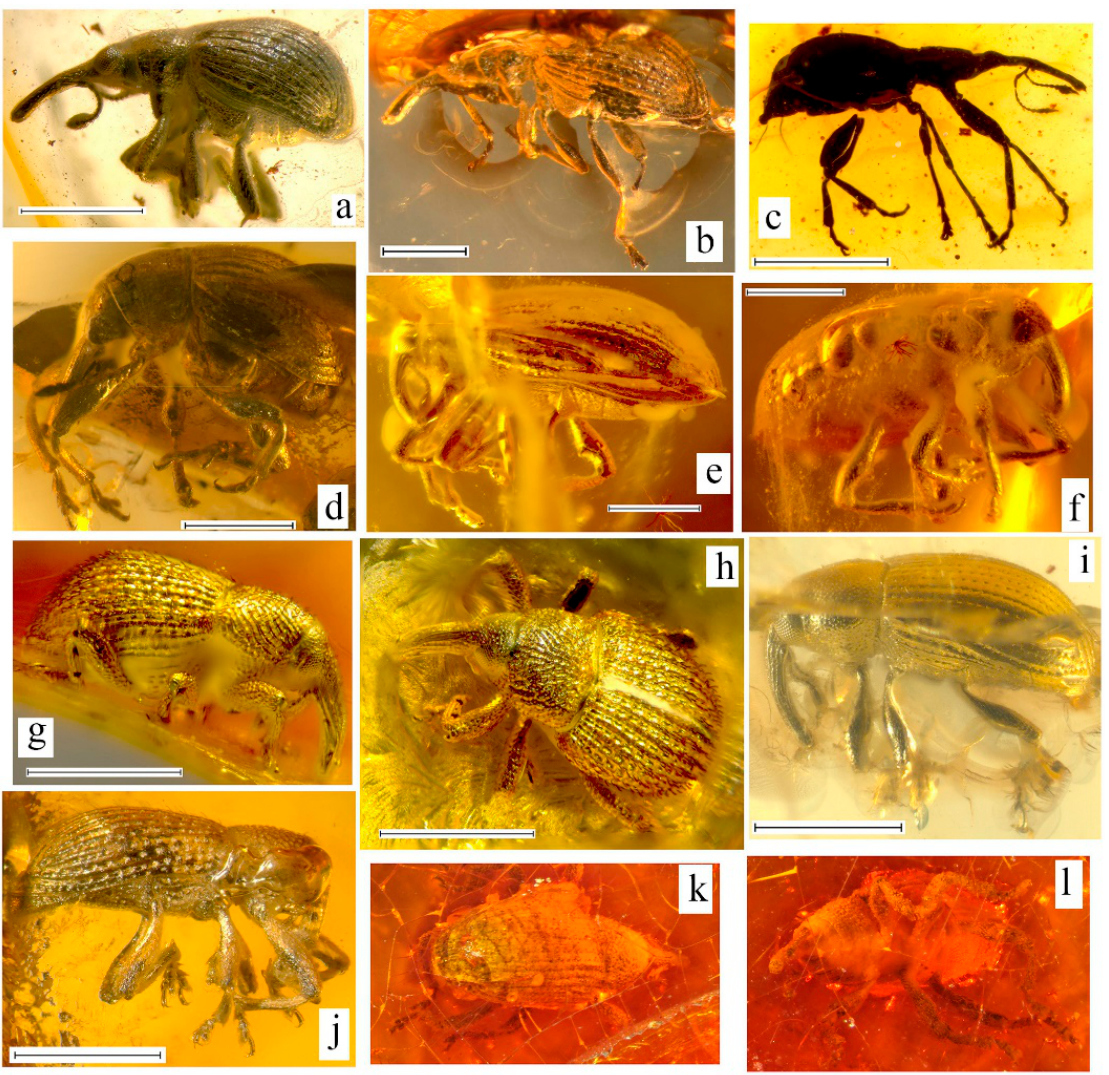
Figure 5. Habitus of Brentidae and Curculionidae from Baltic amber. ( a ) Melanapion poinari , holotype, ISEA , no. BA2013 / 22, body, laterally. ( b ) M. wanati , holotype, ISEA , no. BA2012 / 5, body, laterally. ( c ) Conapium alleni , holotype, ISEA , no. BA2012 / 2, body, laterally. ( d ) Baltonanophyes crassirostre , holotype, ISEA , no. BA2017 / 10, body, laterally. ( e , f ) Dorytomus korotyaevi sp. nov. , holotype, ISEA , no. BA2015 / 6: body, laterally, left ( e ); body, laterally, rigth ( f ). ( g , h ) D. bukejsi , holotype, ISEA , no. BA2019 / 3: body, laterally ( g ); body, dorsally ( h ). ( i ) D. electrinus , holotype, ISEA , no. BA2015 / 5, body, laterally. ( j ) D. nudus , holotype, ISEA , no. BA2013 / 5, body, laterally. ( k , l ) Electrotribus theryi , holotype, CCMCL , no. A6487: body, laterally ( k ); body, dorsally ( l ). Scale bars: 1.0 mm ( a – j ). See Section 2 for names of collections.